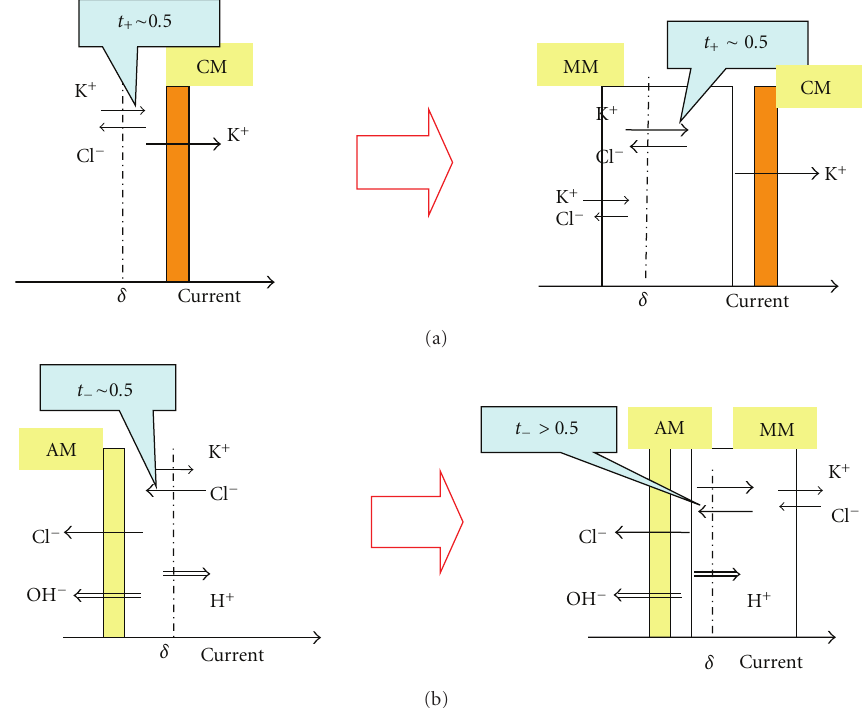
Figure 9: Schematic model of ion transport on the membrane surface. Dotted lines are hypothetical boundary